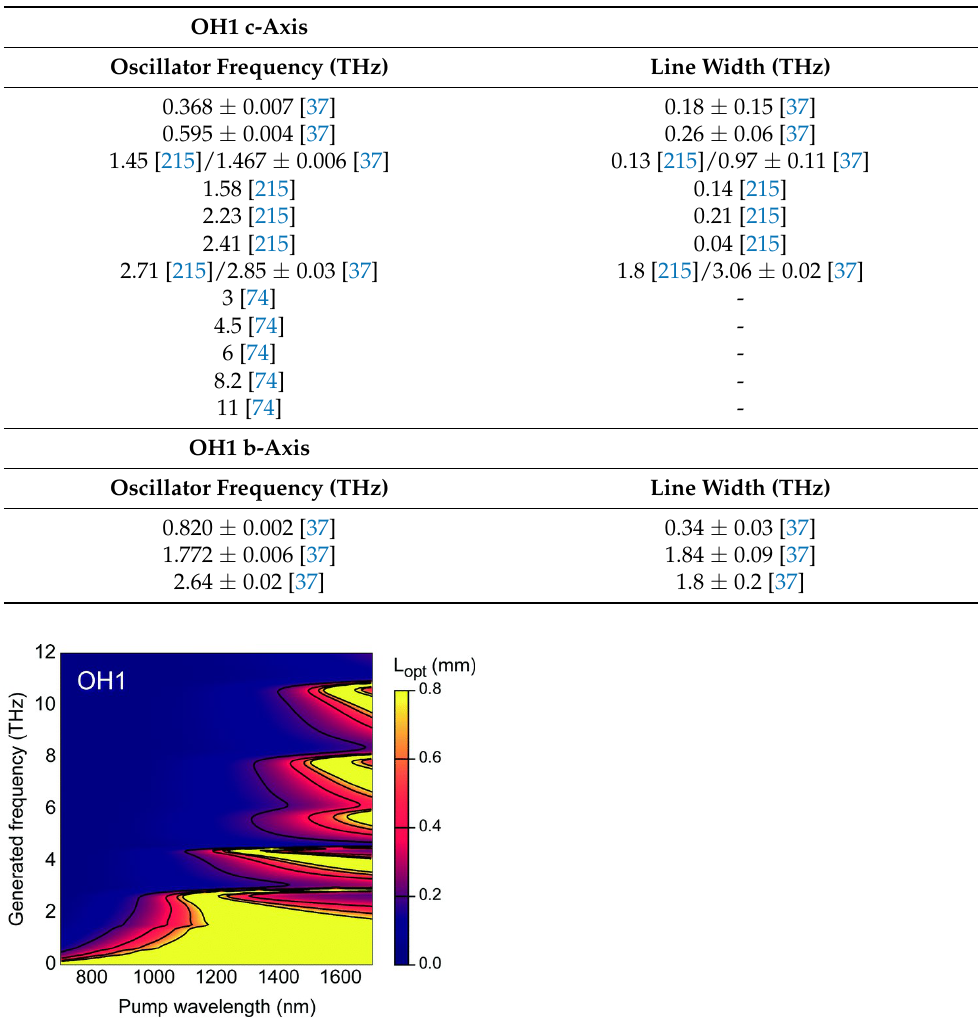
Table 18. Phonon resonances of OH1.